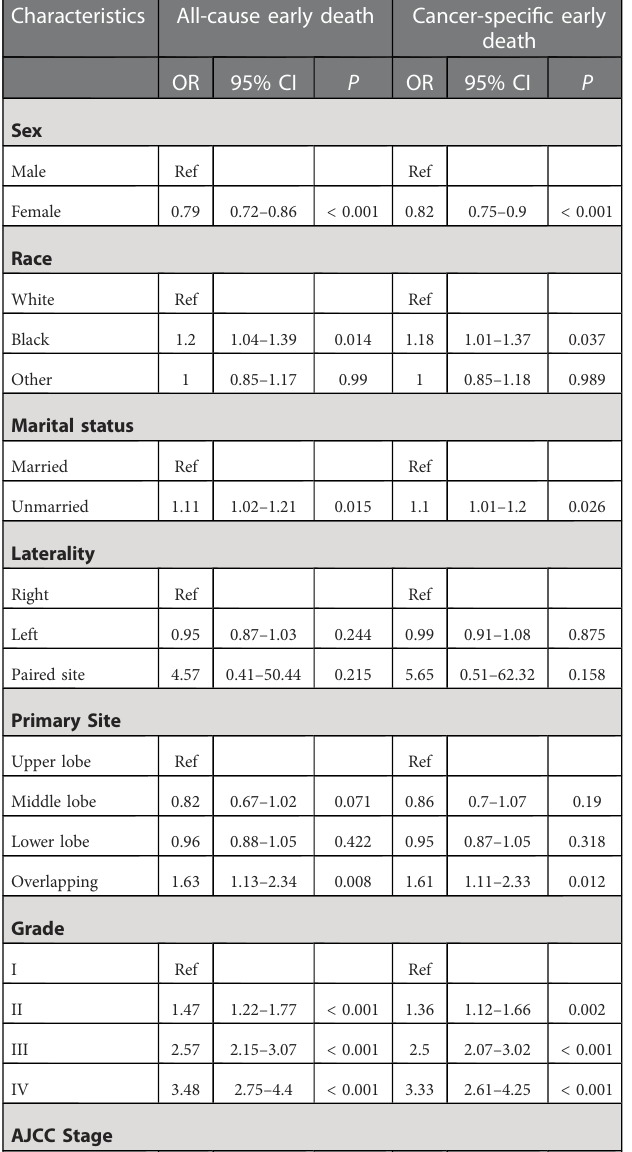
TABLE 3 The univariable logistic regression analysis of all-cause and cancer- speci fi c early death in elderly LC patients.